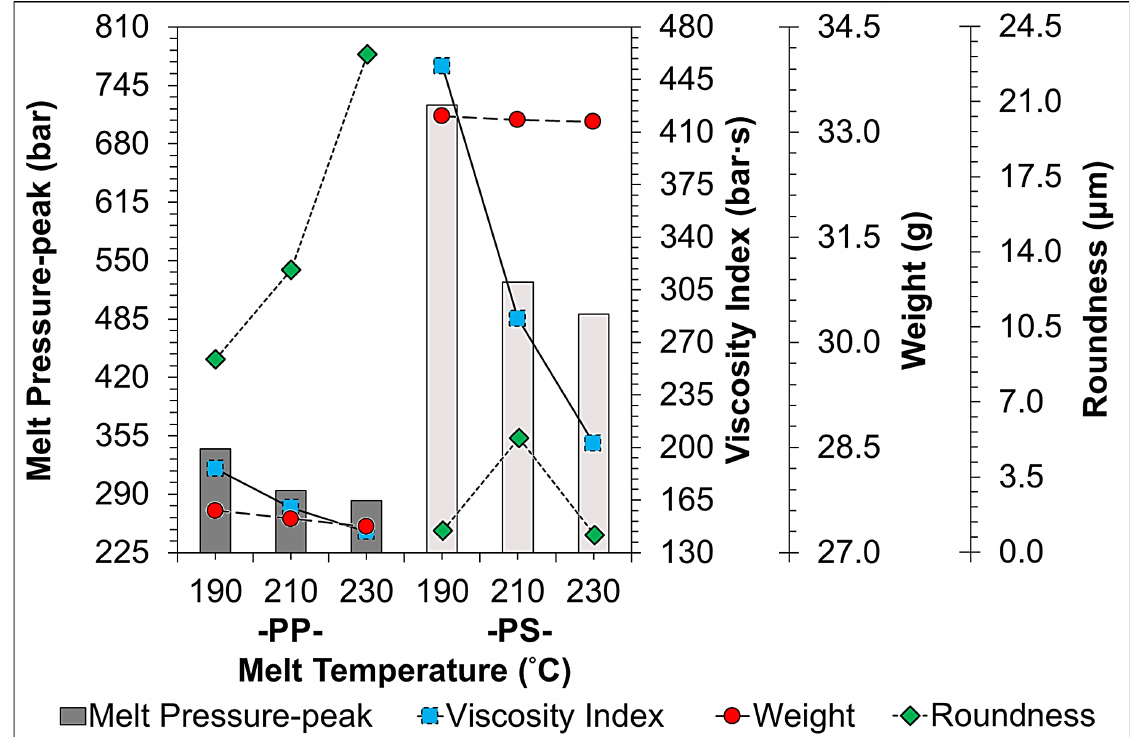
Figure 13. Trend-diagram of the effect of melt temperature on melt pressure-peak (bar-graph), calculated viscosity index (continuous-line), and its sample weight (chain-line)/roundness (dotted-line).